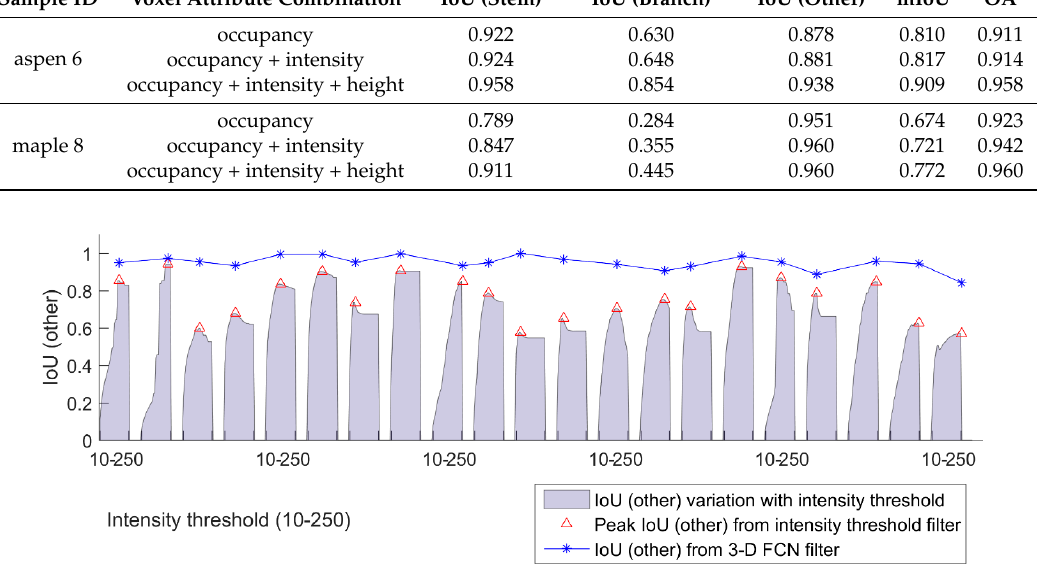
Figure 9. IoU (other) of all the 21 training and testing samples from two filters. The area plot in lavender grey shows IoU (other) variation from an intensity filter based on ‘hard’ thresholds (10–250), with peak IoU (other) in red triangle. The blue starred line shows IoU (other) from a 3-D FCN filter.